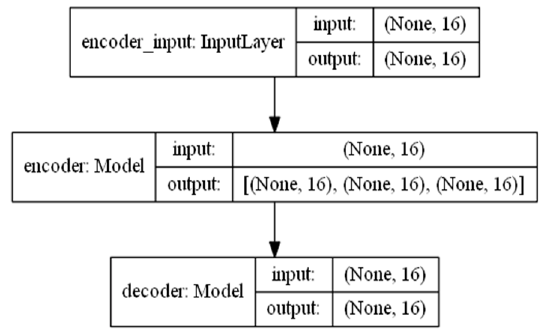
Figure 7. VAE encoding and decoding instantiation process.